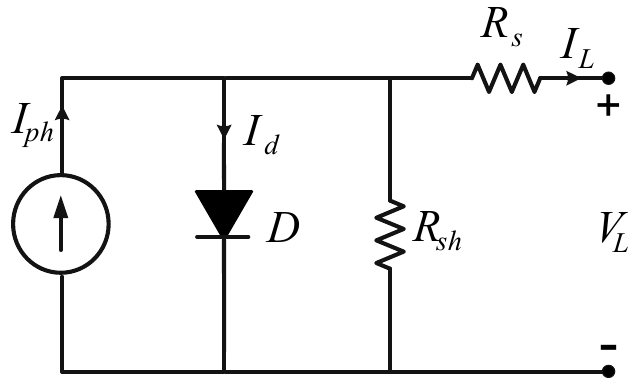
Figure 1. PV grid-connected system.